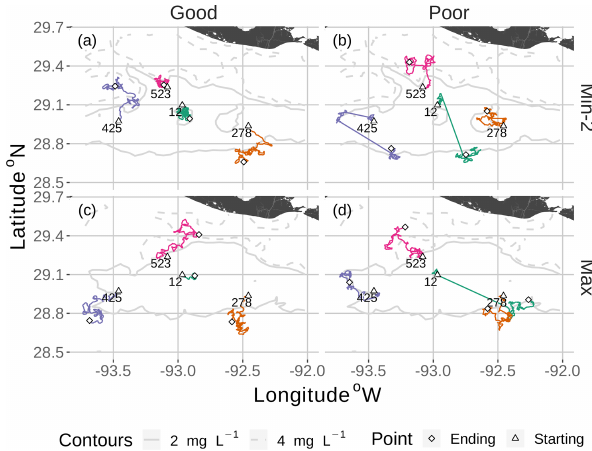
Figure 7. Movement tracks taken by four fish for good and poor hypoxia avoidance (left versus right) and two snapshots (Min-2 for moderate sublethal area and max AUC for high sublethal area). All four fish start (triangle symbol) in the hypoxic zone. These are the same maps as shown in Fig. 3, but here they only show a portion of the model